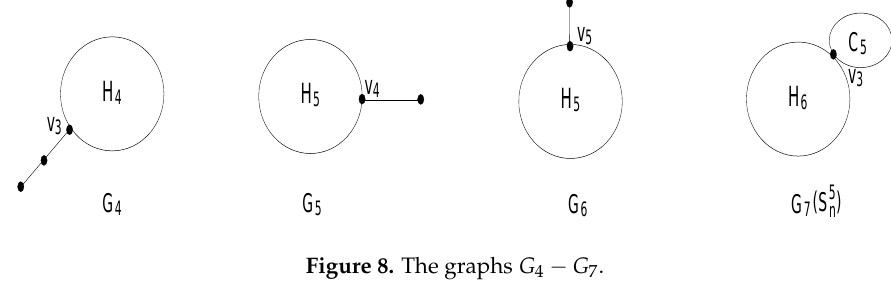
Figure 8. The graphs G 4 − G 7